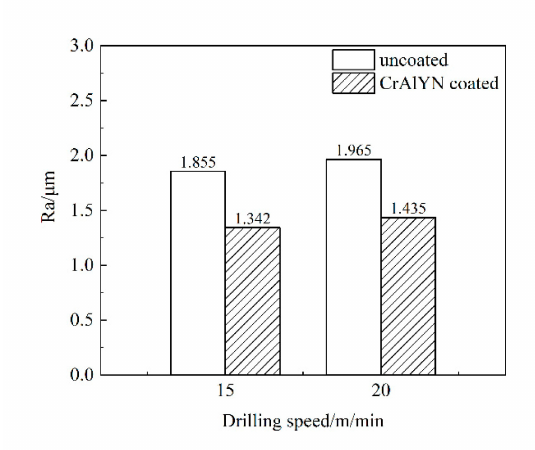
Figure 13. Inner surface roughness